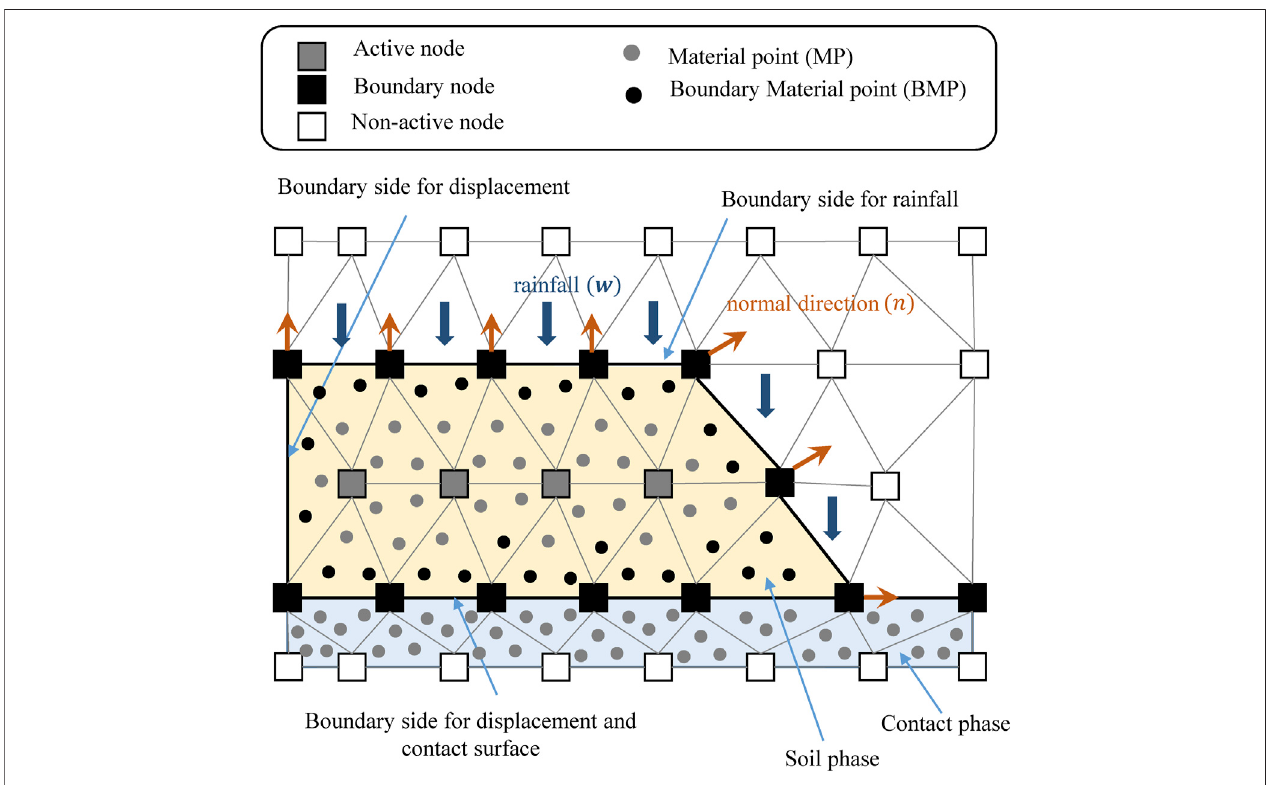
FIGURE 3 | Schematic of the boundary